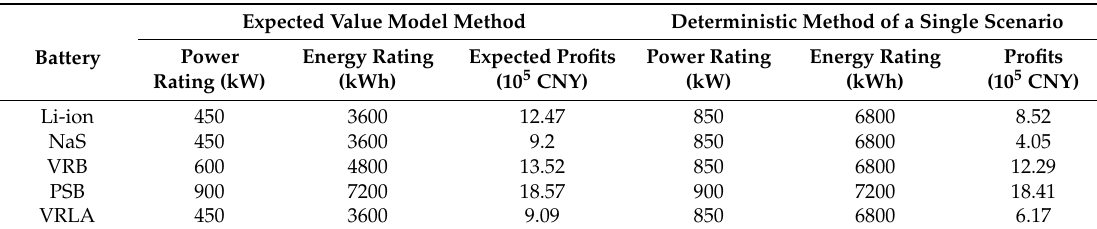
Table 6. The comparison of different batteries’ results obtained by two optimization methods.